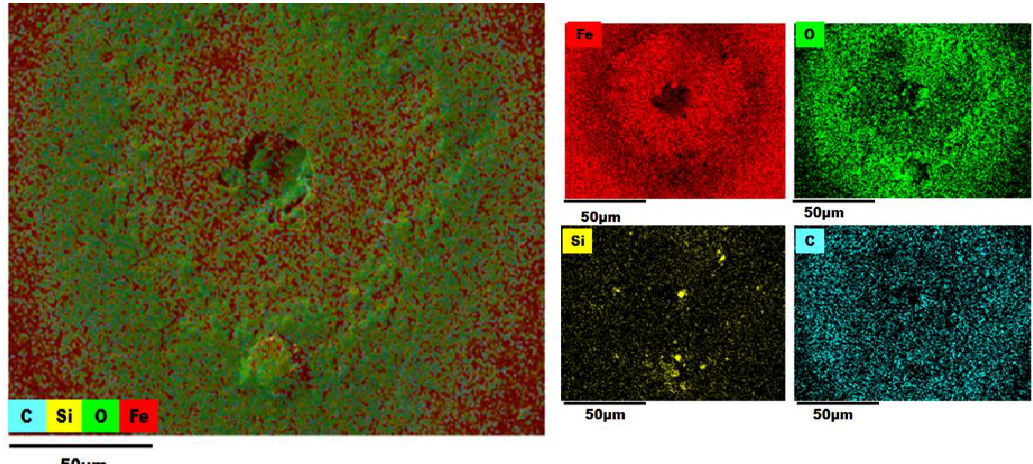
Figure 13. EDS map of a 90° elbow exit surface after the test for 2 wt.% sand fines concentration [8] . Materials 2020 , 13 , x FOR PEER REVIEW